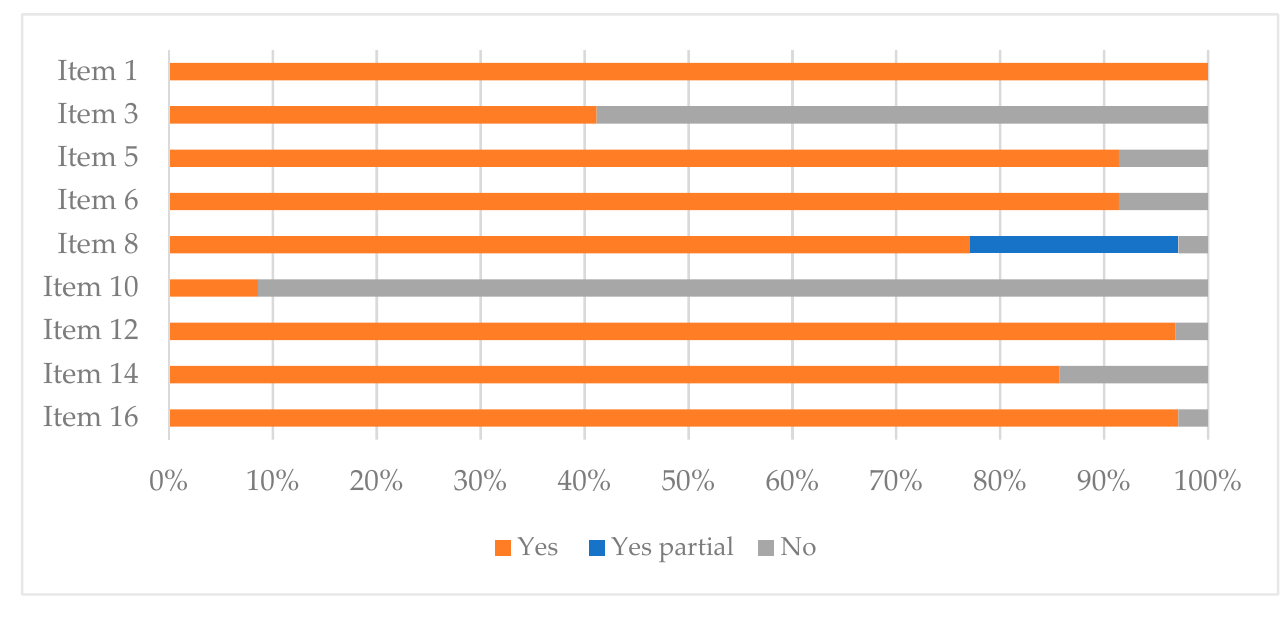
Figure 2. Accomplishment of systematic review with AMSTAR-2 items. ( A ) Critical items. ( B ) Non-